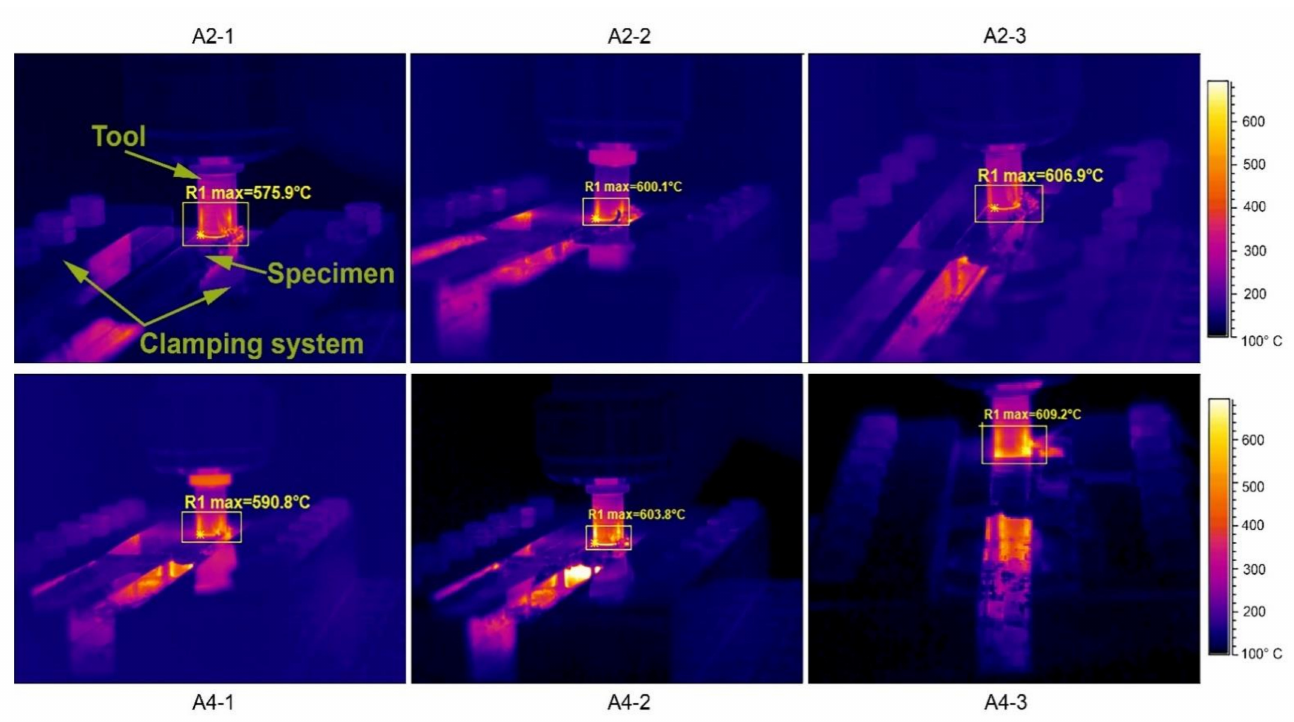
Figure 8. Thermograms of the BTFSW welding